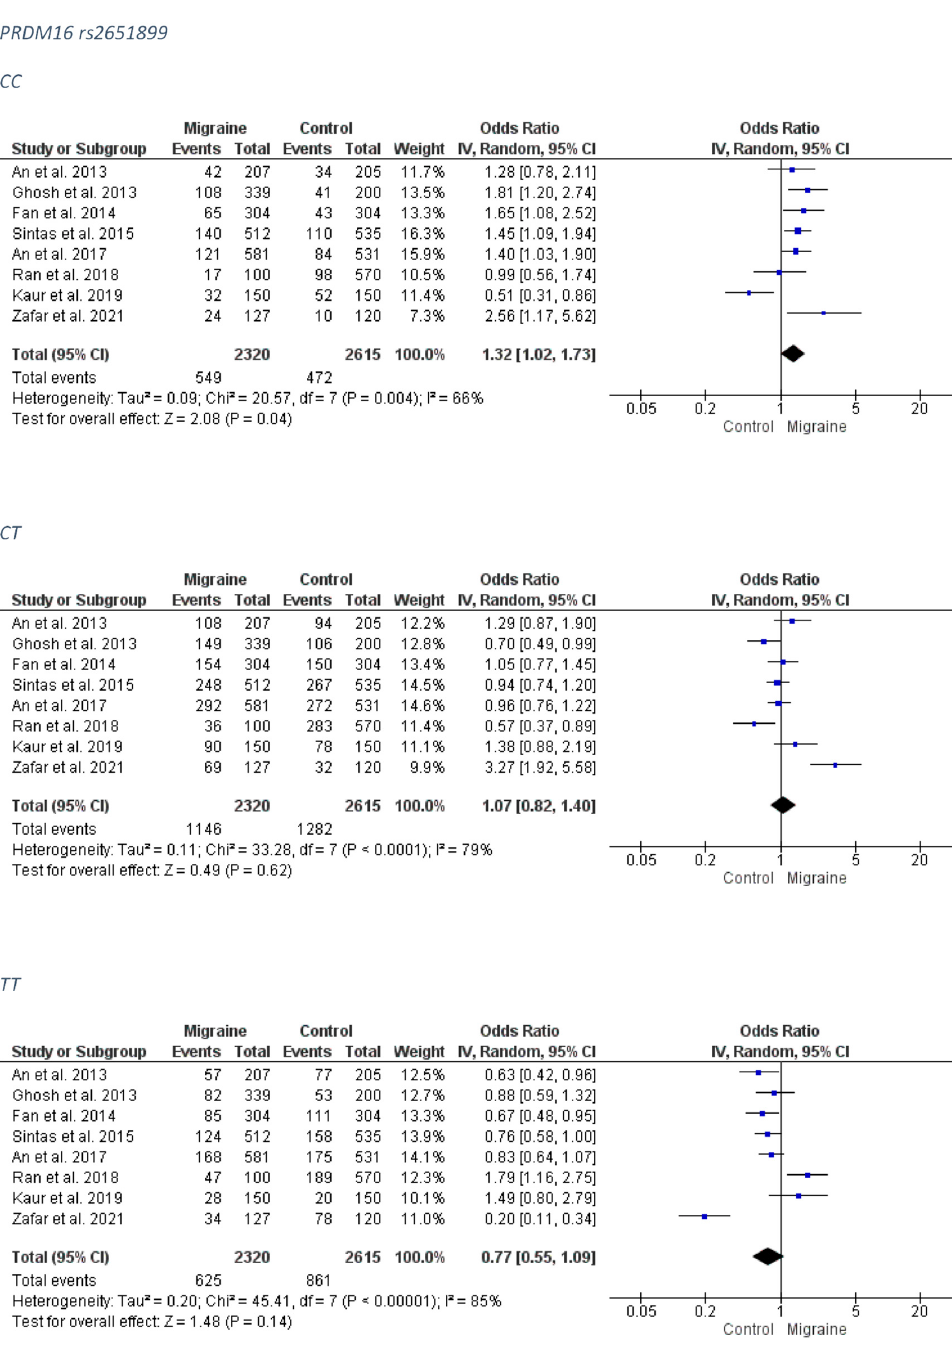
Figure 1. The forest plots presenting the results from meta-analysis of the rs2651899 and overall migraine